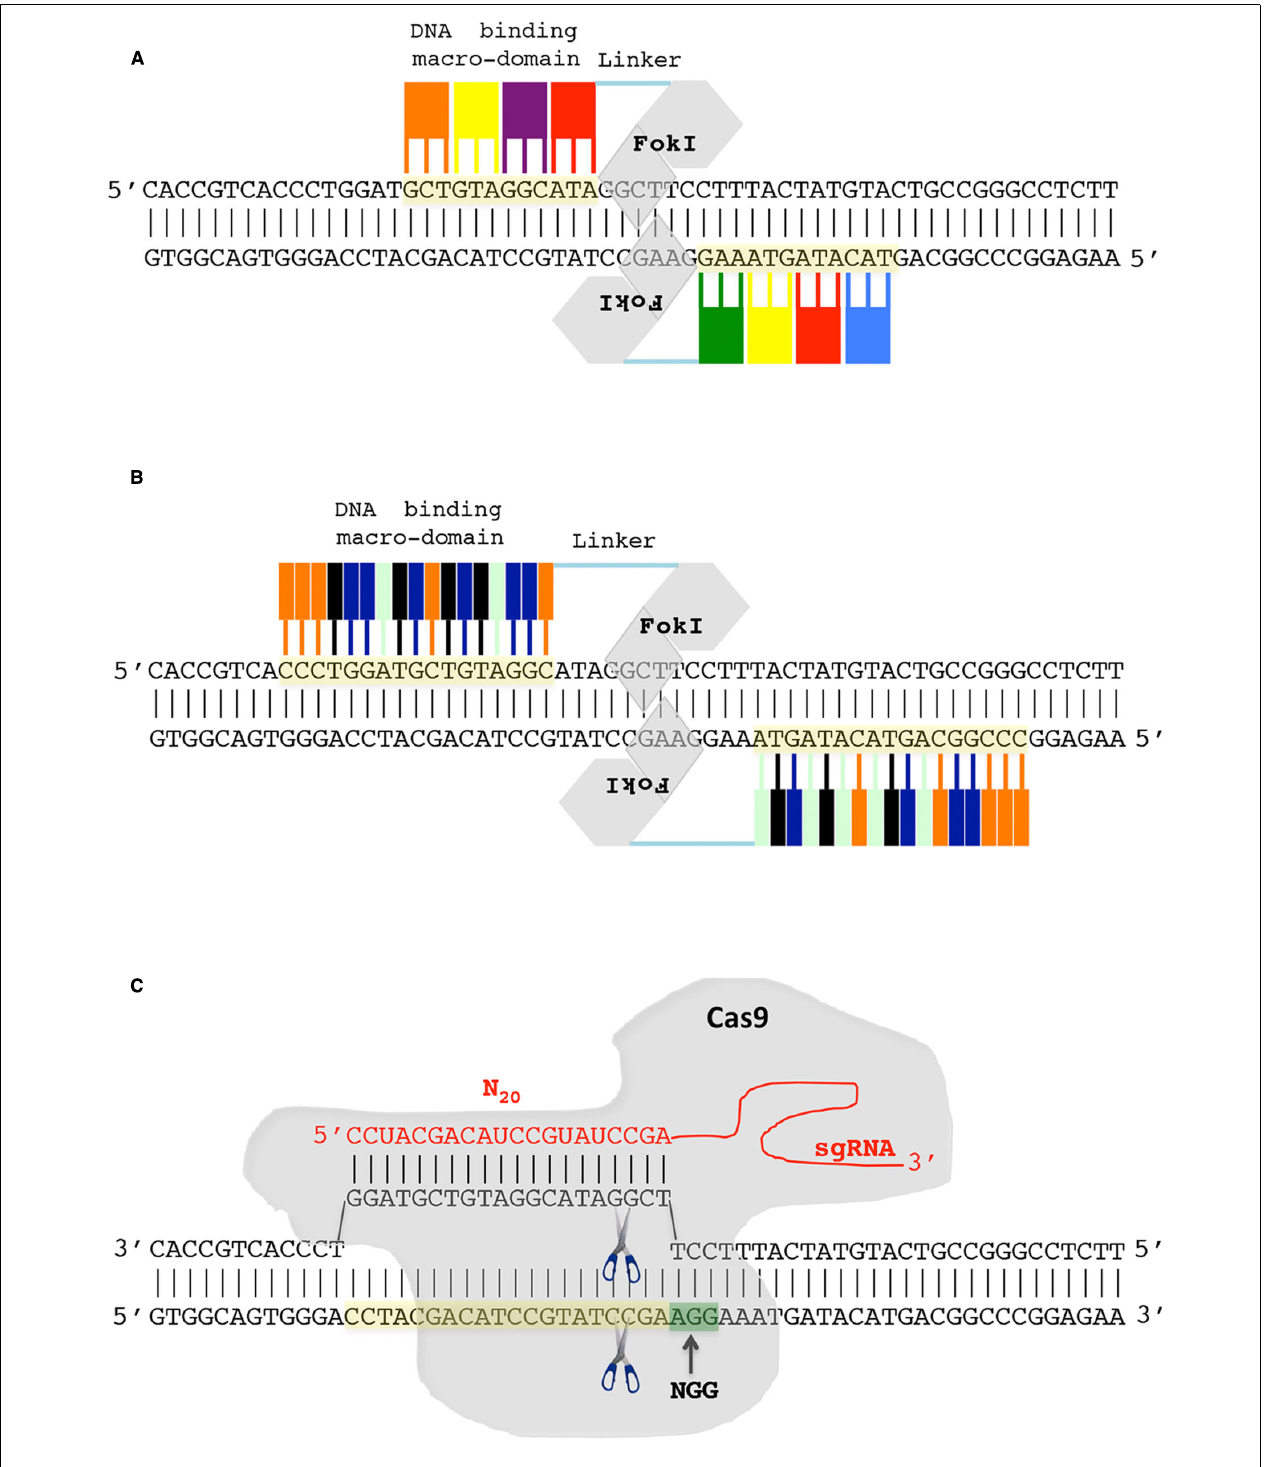
FIGURE 2 | Genome editing using engineered nucleases. (A) Zinc-finger nuclease (ZFN). A pair of ZFNs is required to introduce a double-strand break (DSB). The ZFN DNA binding macro-domain is composed of subdomain each recognizing three nucleotides. The FoKI endonuclease domain of ZFN introduces, after dimerization, the DSB. (B) Transcription activator-like effector nuclease (TALEN). The TALEN DNA